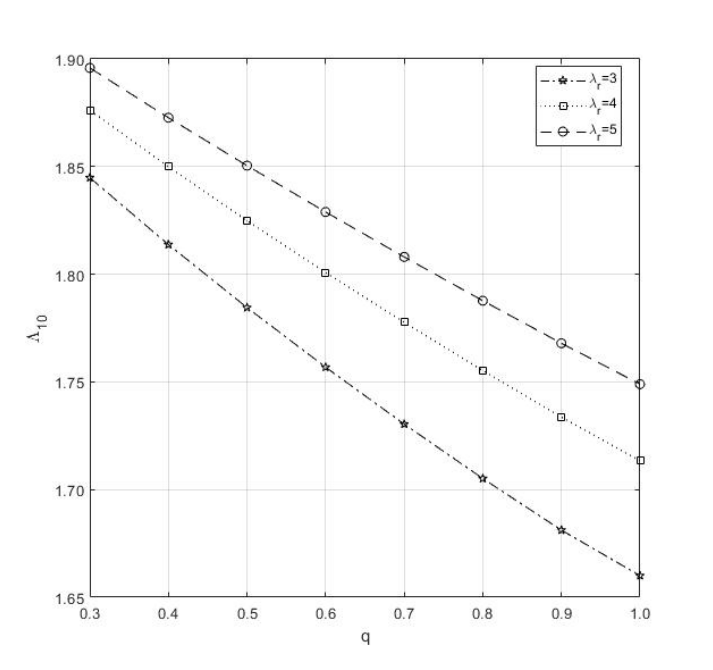
Figure 9. Mean number of Type-I Idle server of λ r vs q